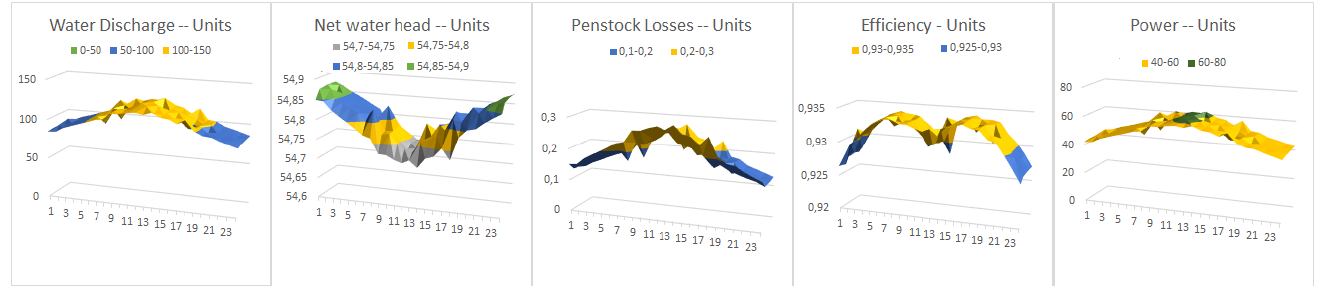
Figure 7. Differential Evolution (best/1/bin)—DEB. Results of Water discharge (m 3 /s). Net water head (m). Penstock (m). Efficiency (%) and Power generated (MW/h). Daily dispatch (24 h).